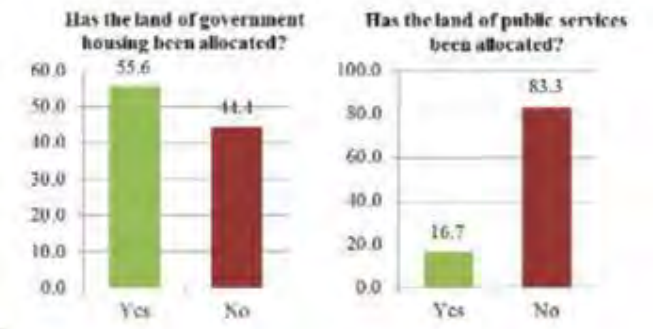
Figure 2. Land allocation forhousing and services